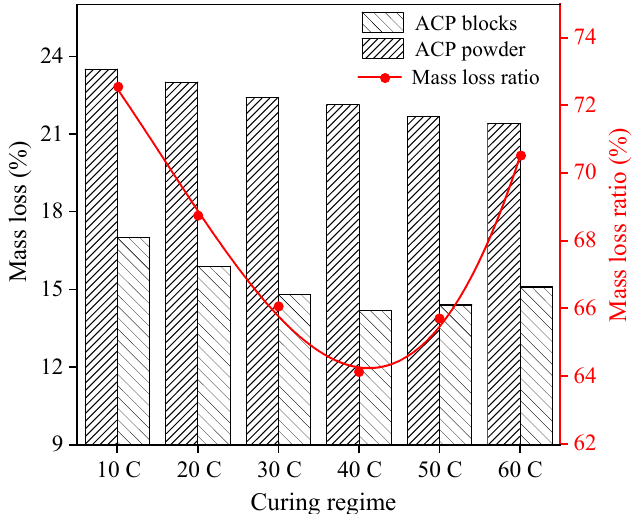
Figure 7. Mass loss of the ACP blocks and ACP powder and their ratio under different early curing regimes.